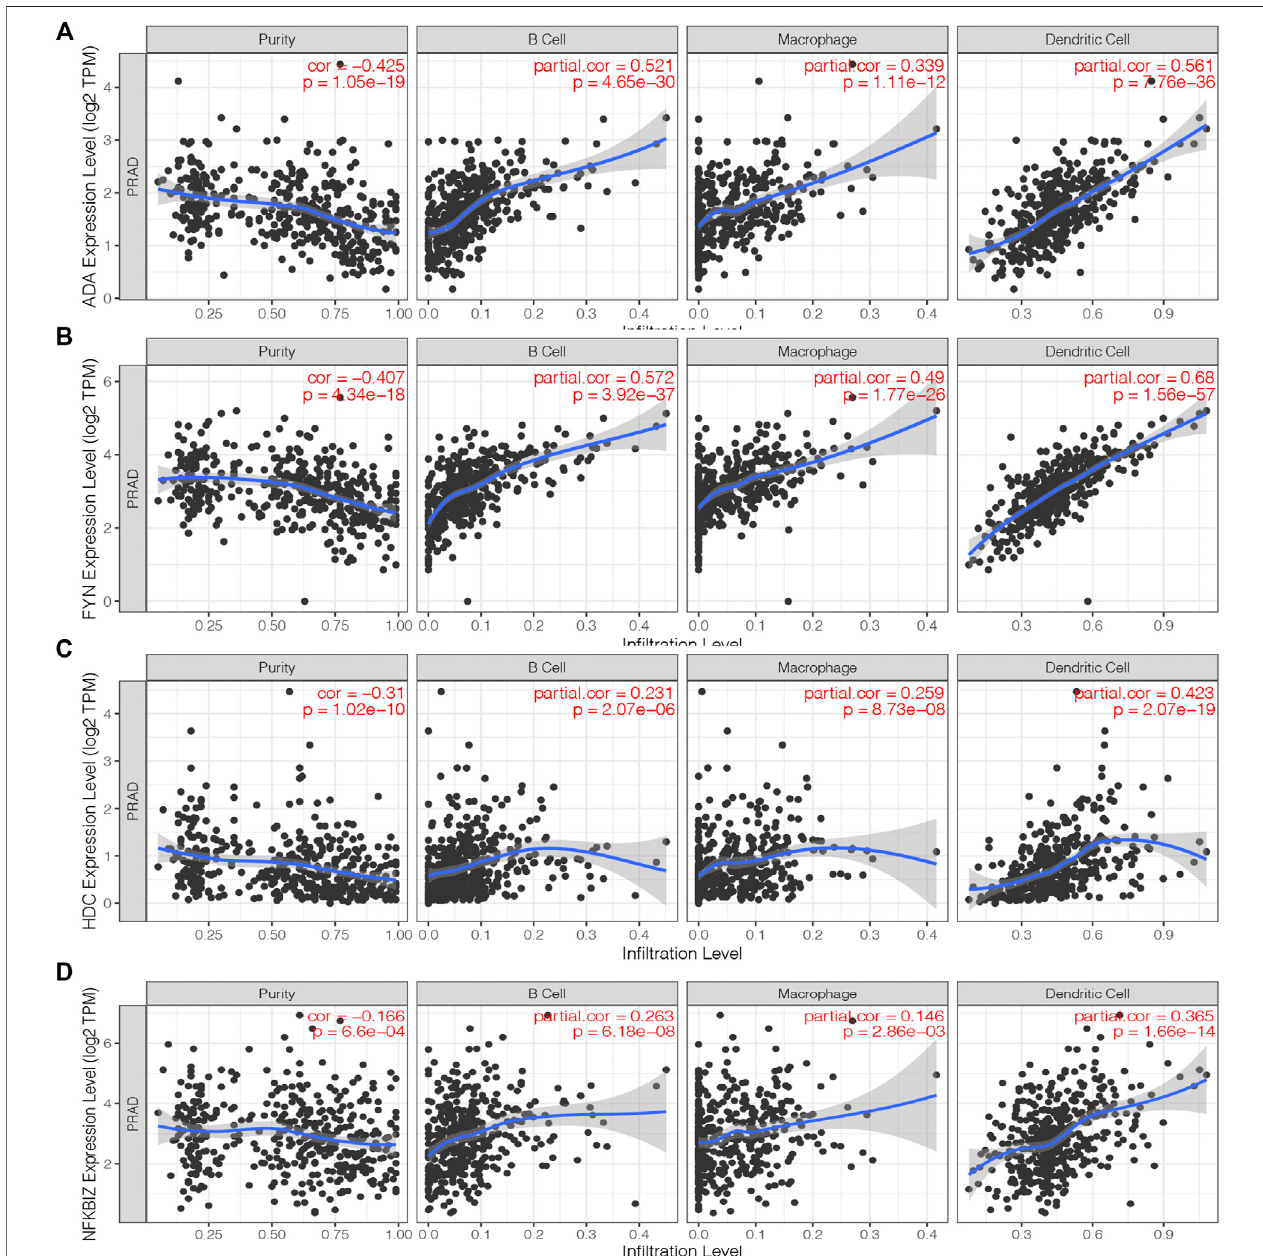
FIGURE 3 | Identi fi cation of tumor antigens associated with antigen-presenting cells. (A – G) Correlation of 7 candidate genes with antigen presenting cells. Association of ADA (A) , FYN (B) , HDC (B) , NFKBIZ (D) , RASSF4 (E) , SLC16A3 (F) and UPP1 (G) expression with the purity of in fi ltrating cells and amount of macrophages, dendritic cells and B cells in